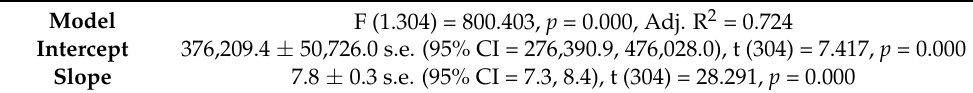
Table 2. Characterization of the regression model relating the 16S rRNA abundance (dependent variable) to the Hsp70 abundance (independent